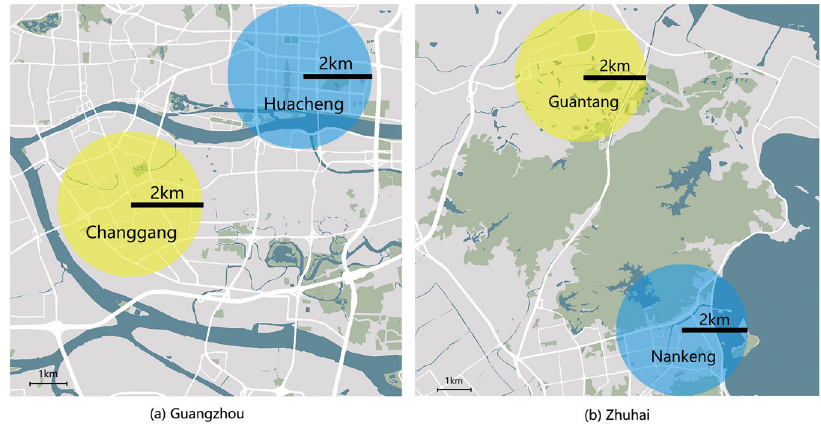
Fig. 1 Relavtive location of the case communities. Guangzhou is on the left with Changgang and Huacheng community. Zhuhai is on the right with Guantang and Nankeng community.